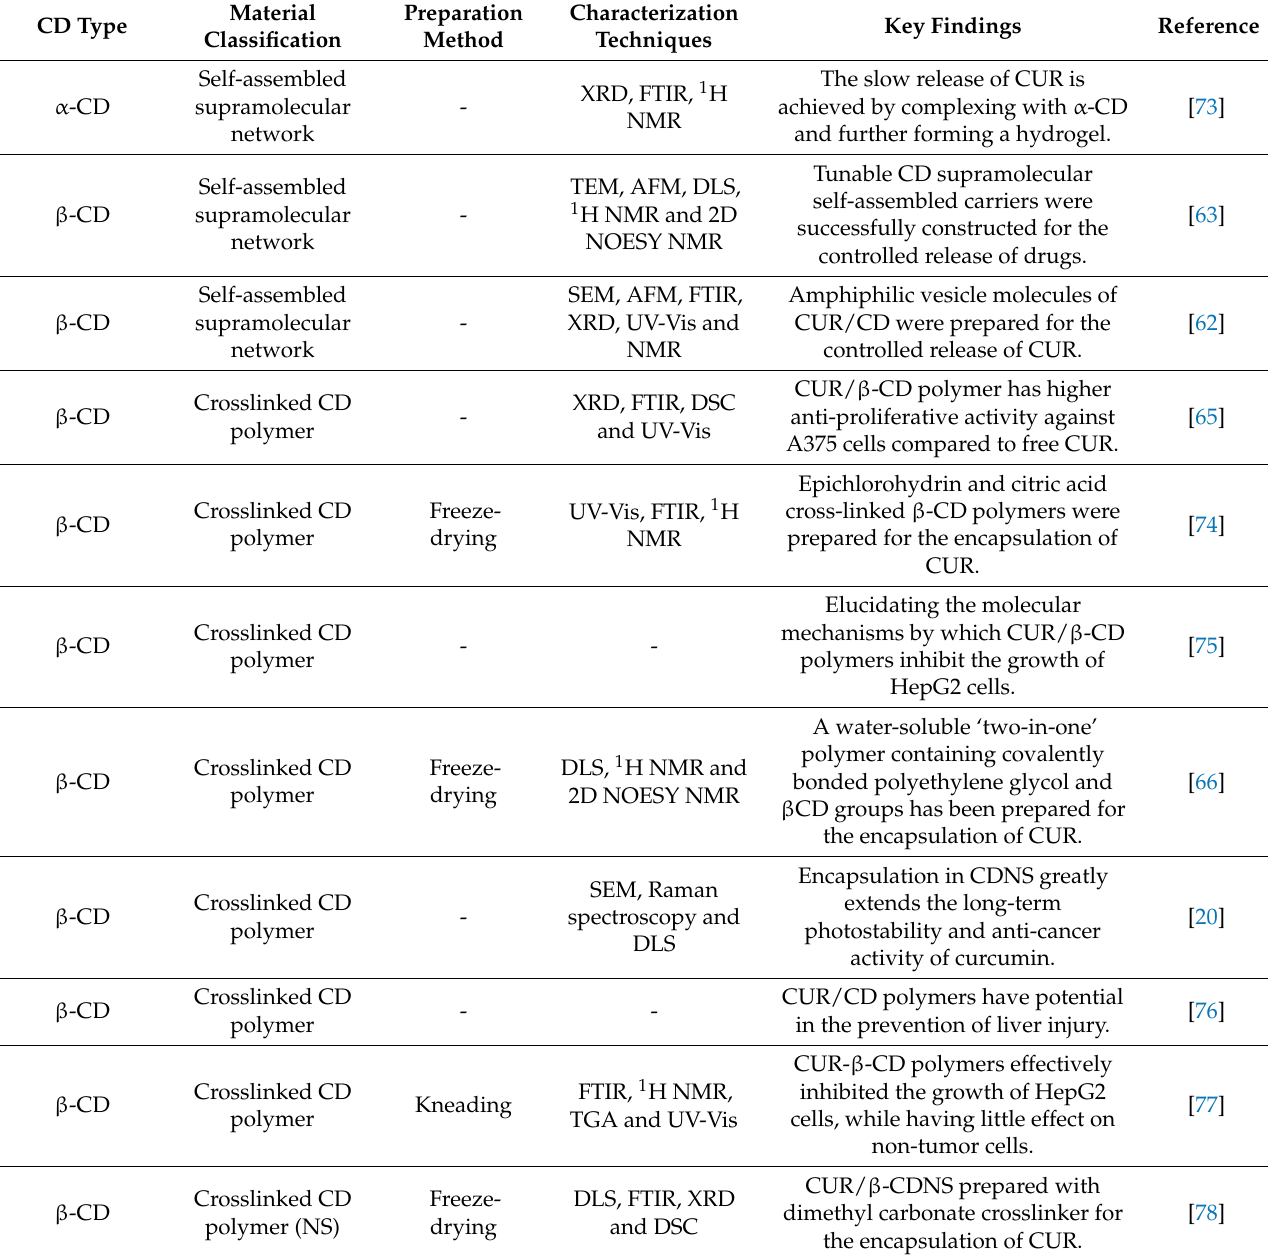
Table 2. Summary of various cyclodextrin polymer-coated curcumin